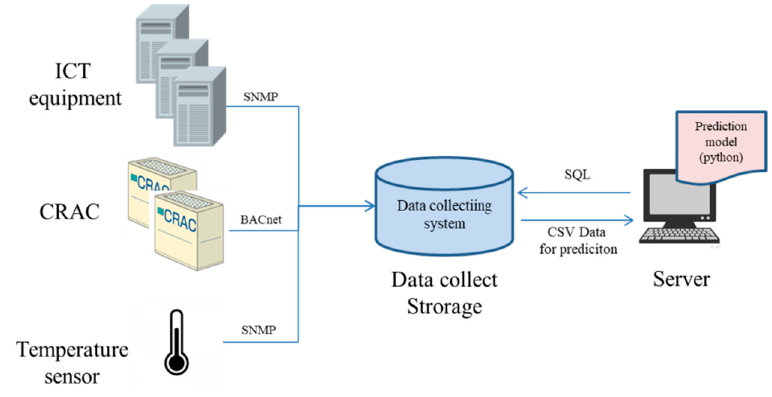
Figure 2. System configuration. Table 2. CRAC operation patterns and stop times.